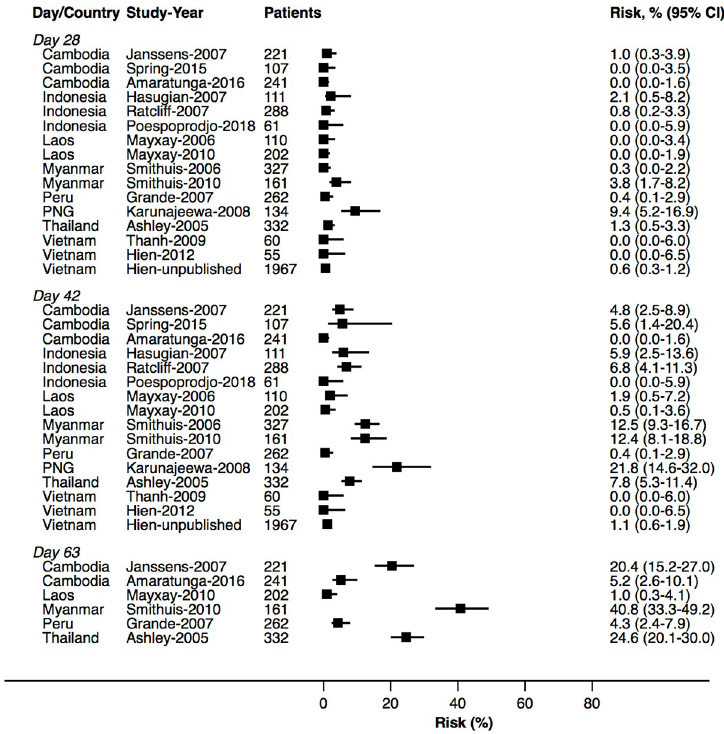
Fig 6. Cumulative risk (Kaplan–Meier analysis) of P . vivax parasitaemia after P . falciparum infection by study for DP. DP, dihydroartemisinin-piperaquine.